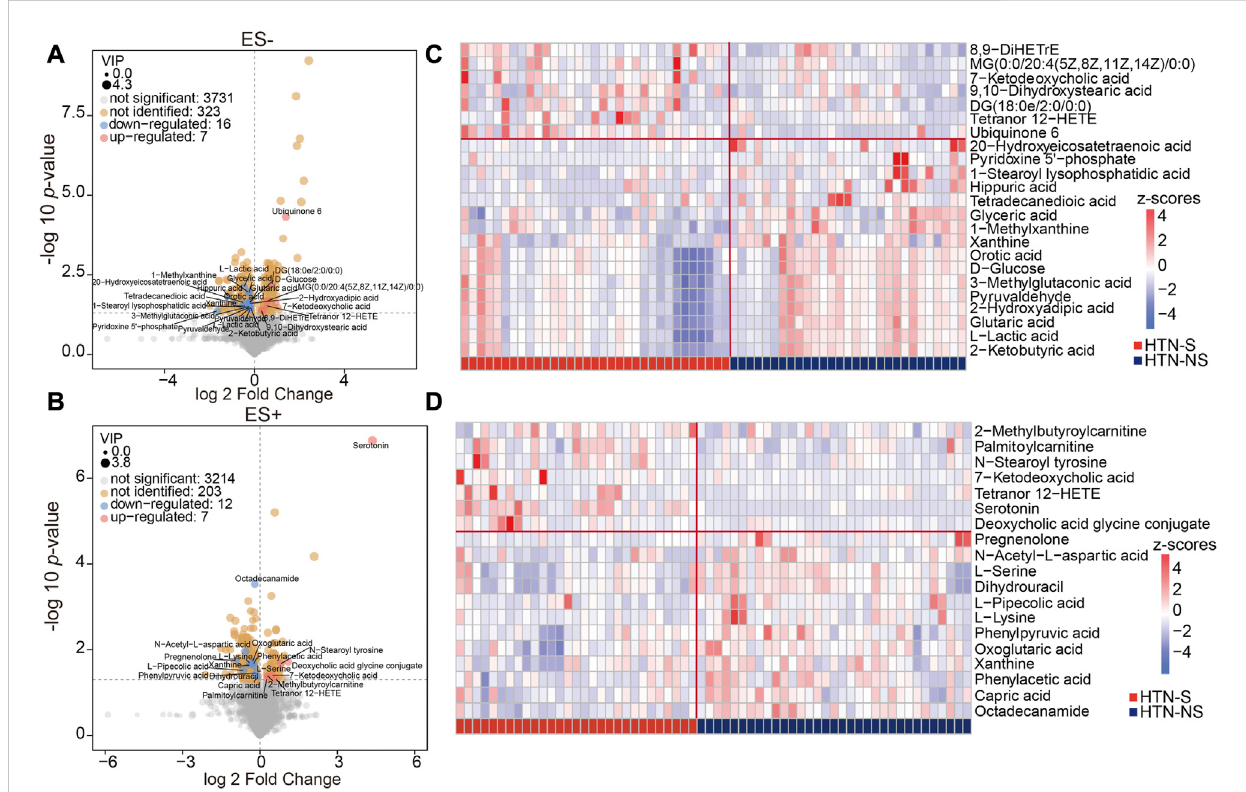
FIGURE 2 Identi fi cation of the differential metabolites associated with smoking and non-smoking HTN. (A, B) , Volcano plots showing the important metabolitesconcludedfromtheOPLS-DAmodelusingathresholdofvariableimportancefortheprojection(VIP) > 1.Aisbasedonmetabolomicsdatain ES- mode, and B is in ES- mode. Comparison of the relative abundance of each metabolite in groups was further validated using the p values from two- tailed Student ’ s t-test. Each dot represented a metabolite, blue denoted downregulated ones, and pink represented those upregulated in smoking HTN. The value of VIP was expressed as the dot size. Among the varied metabolites between groups, those successfully identi fi ed were further labeled with names. (C, D) , Hierarchical cluster analysis heat-maps of identi fi ed metabolites with signi fi cant disparate levels between smoking HTN patients and non-smoking controls. The relative abundance of each metabolite in each individual is